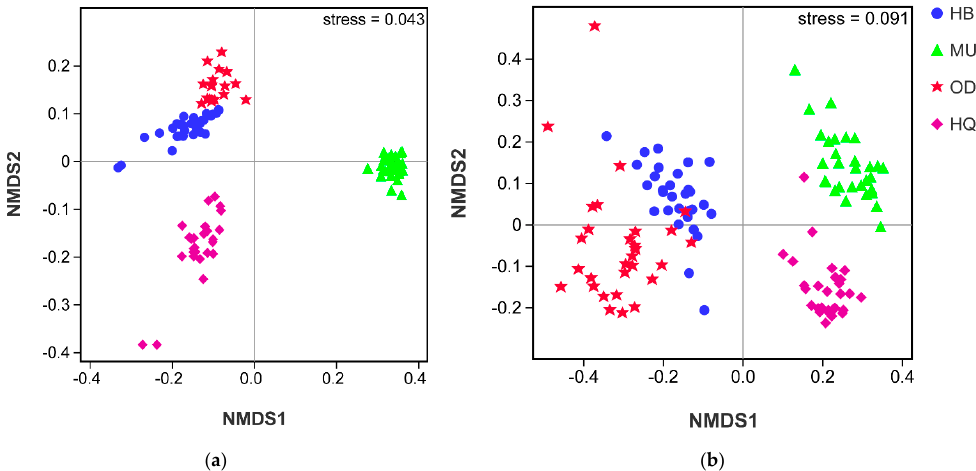
Figure 4. Bacterial ( a ) and fungal ( b ) community structure based on unweighted UniFrac distance, as determined by non-metric multidimensional scaling (NMDS).